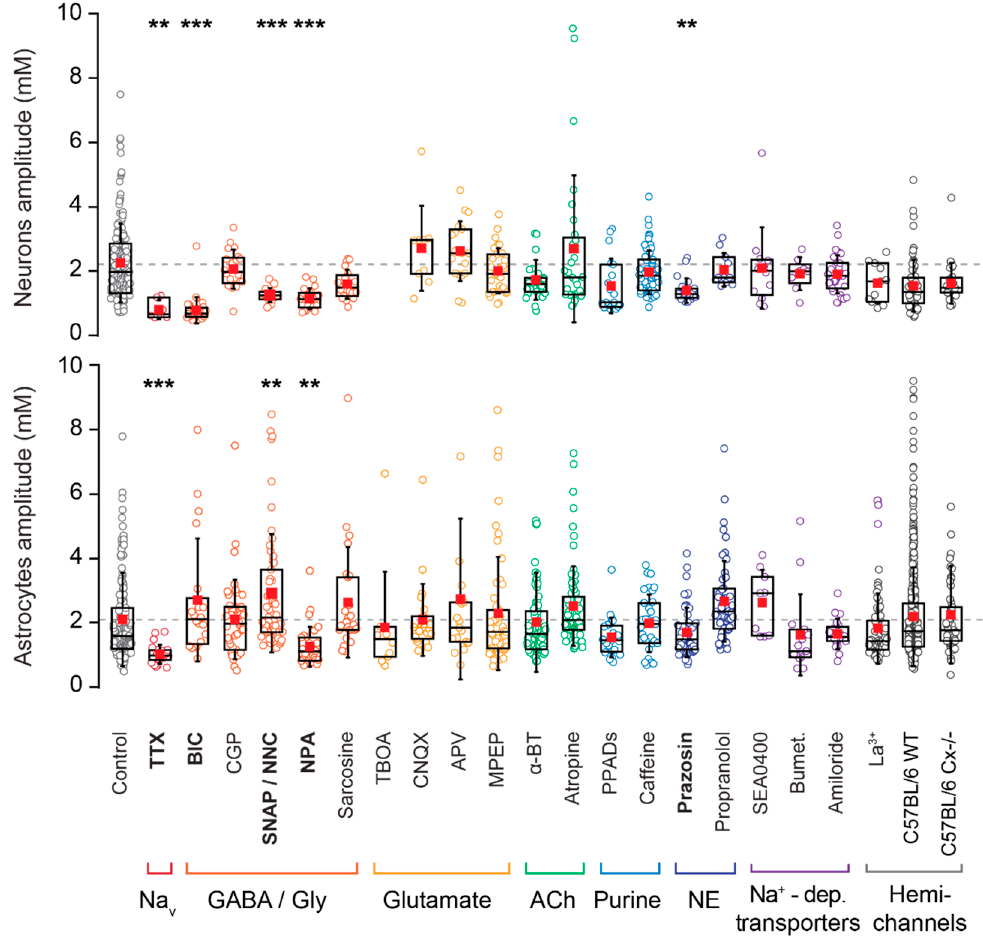
Figure 5. Pharmacological investigation. Comparison of fluctuation amplitudes in neurons and astrocytes in the presence of various pharmacological conditions as detailed in Tables 1 and 2. Blockers are arranged into color groups according to their target pathway as indicated below the plots.